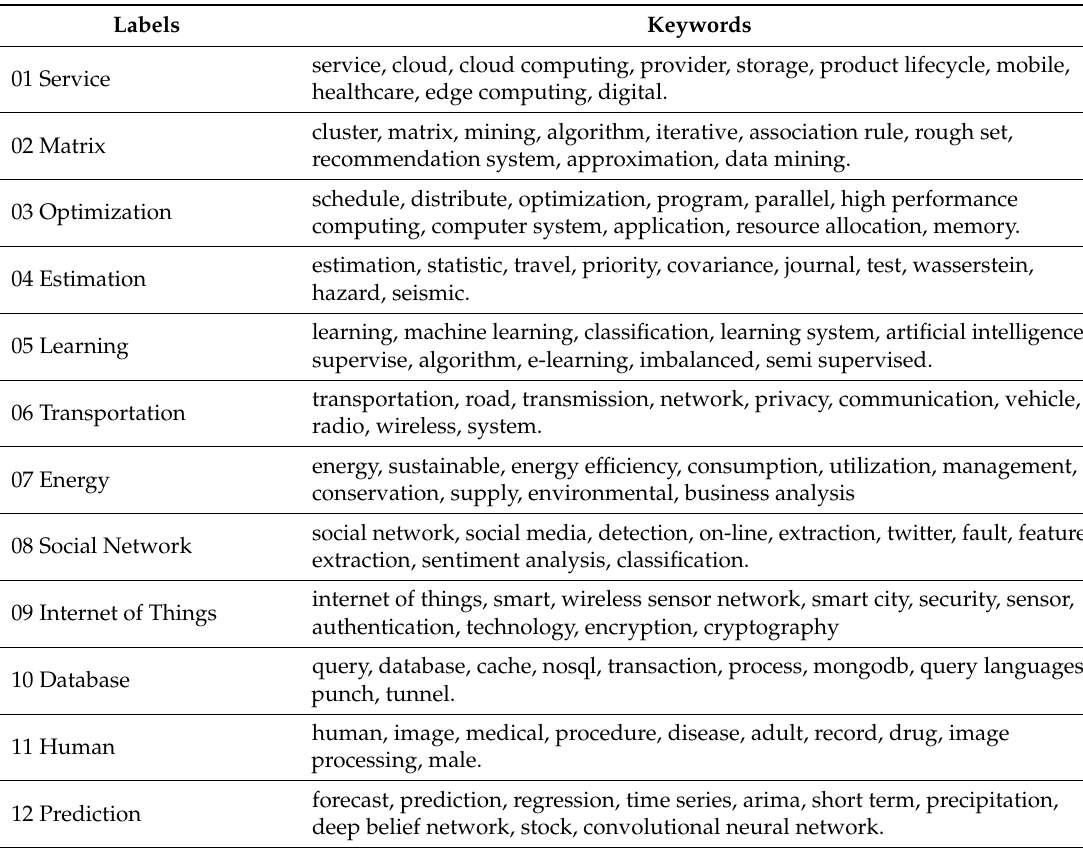
Table A5. Top 10 characteristic keywords in each cluster for